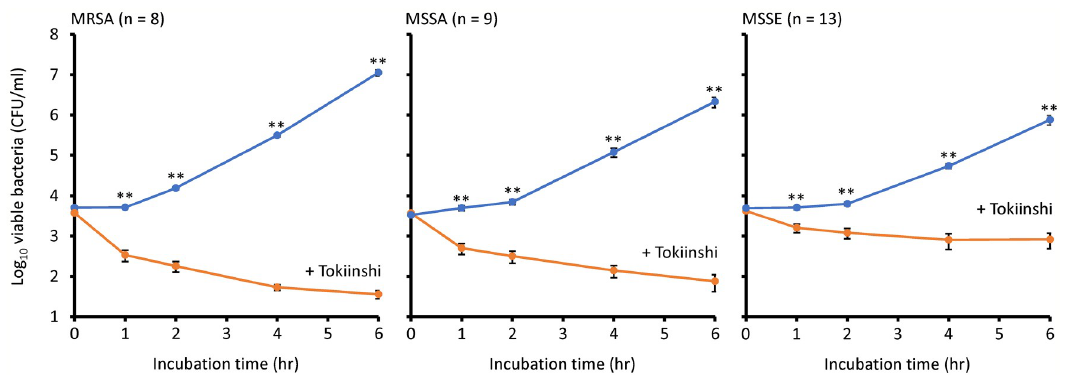
Fig 3. Growth inhibition effect of Tokiinshi (20 mg/ml) against clinical MRSA, MSSA, and MSSE strains. MRSA, methicillin- resistant Staphylococcus aureus . MSSA, methicillin-susceptible Staphylococcus aureus . MSSE, methicillin-susceptible Staphylococcus epidermidis . �� P <